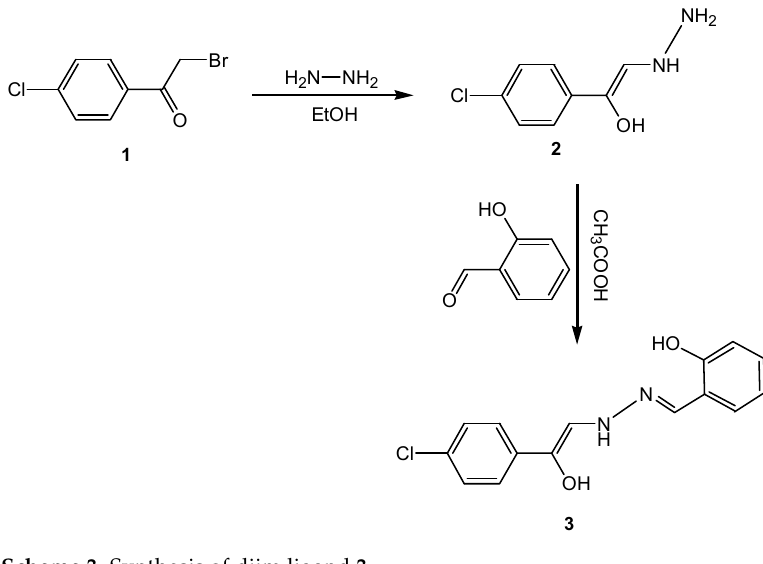
Figure 3. Mass spectrum fragmentation of the diim ligand.